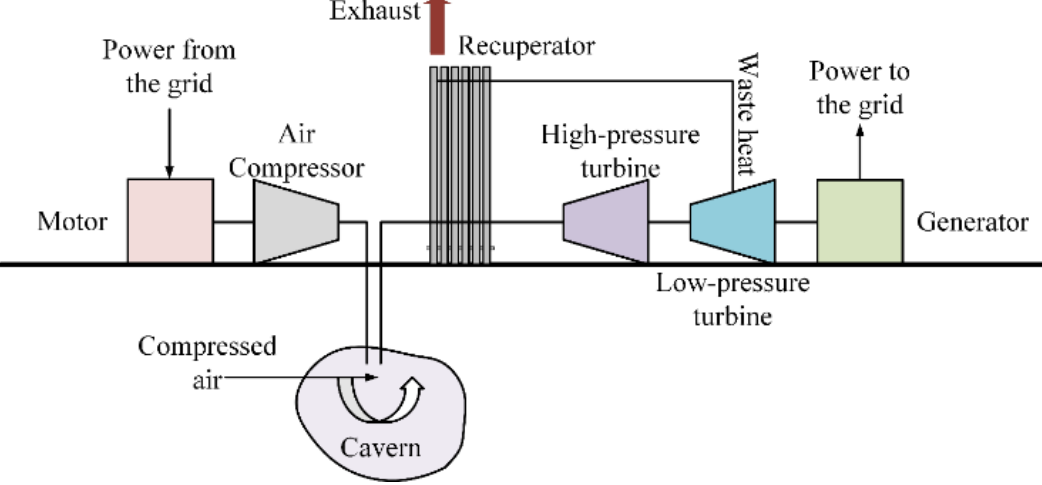
Figure 6. Schematic diagram of a compressed air energy storage (CAES) Plant. Air is compressed inside a cavern to store the energy, then expanded to release the energy at a convenient time. Table 2. Existing pumped hydro storage projects in the United States [30].